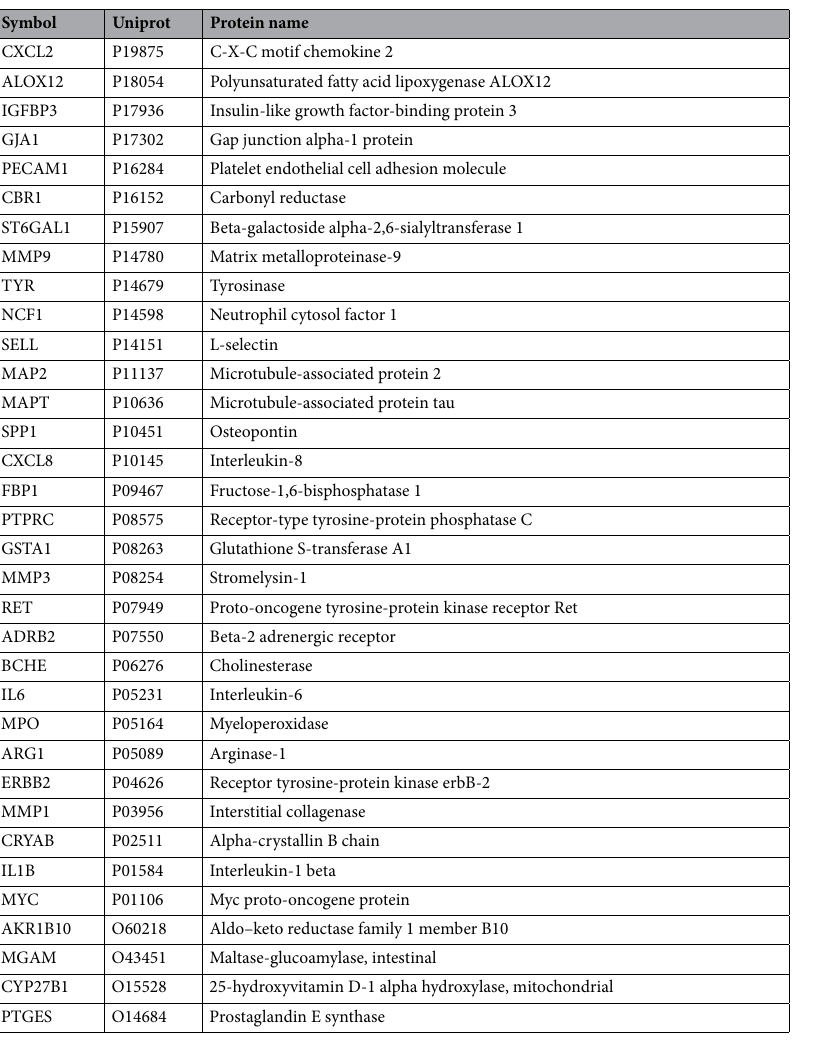
Table 2. Information on 90 crossed target